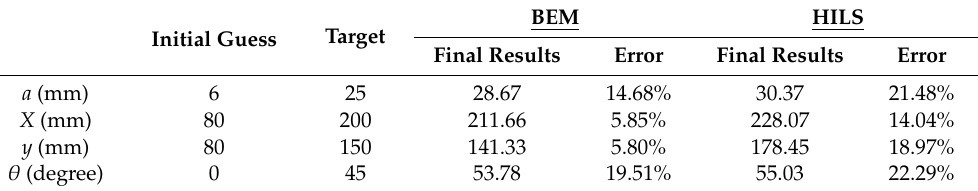
Table 6. Crack identification of composite